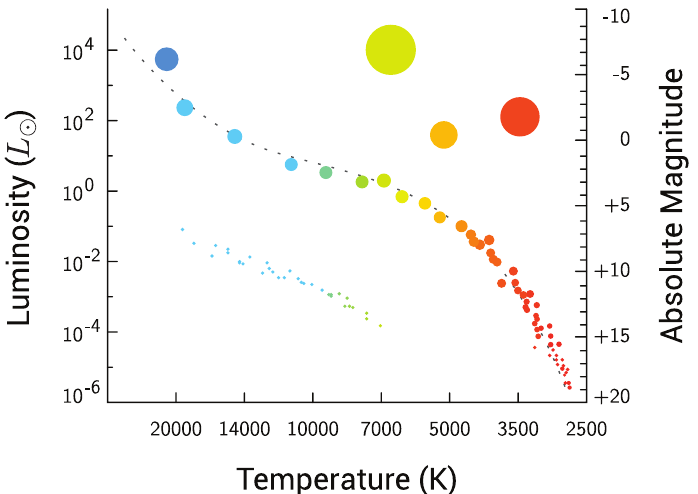
Figure 5. Hertzspring and Russel diagram: luminosity (in terms of the Sun luminosity) as a function of the star temperature. Notice that the temperature increases from right to left. The yellow, orange, and red big dots on the right top represent red giants, the blueish sequence on the bottom left represents white dwarfs, and the central line is the main sequence, where the red stars are red dwarfs and the blue ones are blue